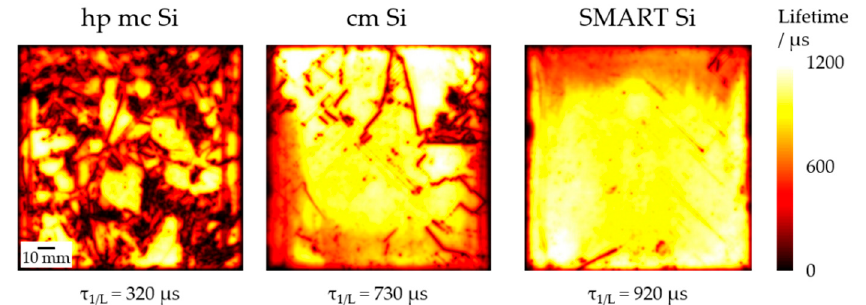
Figure 7. Lifetime images of bulk lifetime samples after a process chain typical for TOPCon process of hp mc Si, cm Si, and SMART Si wafers at an illumination of 1/20 suns and an ingot height of 130 mm. The hp mc Si material was crystallized in a similar experiment but features a lower resistivity of 0.5 Ω cm while the cm Si and SMART Si material feature a resistivity of 0.9 Ω cm. Obviously, all three materials show a difference in recombination active structural defects reducing the lifetime as expected. While the amount of grain boundaries and dis- locations is strongly decreased from hp mc Si to cm Si, the SMART Si material shows even less. A large fraction of the lifetime deterioration in the cm Si and SMART Si is not due to the material but rather process-related artefacts like the area of reduced lifetime at the lower (cm Si), respectively upper edge (SMART Si). Highest effective lifetime values at 1/20 suns are around 1200 µs for all three materials in the inner grain and mono area. The influence of the structural defects is very pronounced at the depicted measurement at 1/20 suns, which illustrates the injection condition of a final solar cell at 1 sun at the maximum power point. This minimized lifetime reduction at working conditions is a further ad- vantage of the SMART Si material. Due to the promising material quality of the SMART Si, this material was used as the base material of a TOPCon solar cell [15]. A sample from the previously shown ingot height of 130 mm and a resistivity of 0.9 Ω cm obtained the certified record efficiency of 23.3% (V oc = 699 mV, J sc = 40.9 mA/cm², FF = 81.5%) [21]. The sample was textured with random pyramids and was processed with a double layer anti-reflection coating. 5. Conclusions The SMART approach was successfully transferred to a G2-sized silicon ingot ena- bling better material quality than the standard cm Si. The blocking of parasitic grains was effective in such a way that the monocrystalline area could be held higher than 90% all over the ingot height, which is a big improvement compared to the cm Si with a mono area declining to 50%. In addition, an improved control of the other crystal defect, dislo- cations, was reported. The confinement of dislocations in the functional defects was rela- tively stable but has still room for future improvement, where different compositions of the functional defects could be evaluated. A recombination active cellular structure was observed in the monocrystalline area which could be correlated with the dislocation dis- tribution even if the dislocation density is low. It could not be clarified yet if these cellular structures limit the material quality for solar cells. Lifetime measurements after a typical high temperature process chain would be useful for this evaluation. The comparison of the material quality of SMART Si, cm Si, and hp mc Si at 130 mm showed a clear benefit of the SMART Si material due to its high homogeneity and low defect density. This SMART Si material was processed as a TOPCon solar cell and obtained a certified record efficiency of 23.3%.